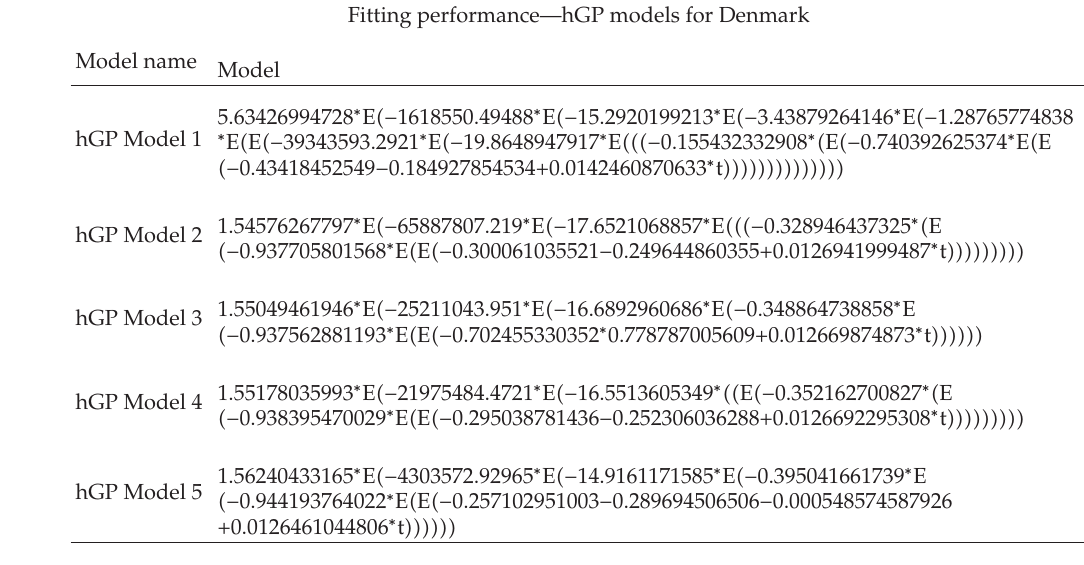
Table 27: Representation of the first five produced hGP models in fitting (cid:2) Denmark (cid:3) . Fitting performance—hGP models for Denmark